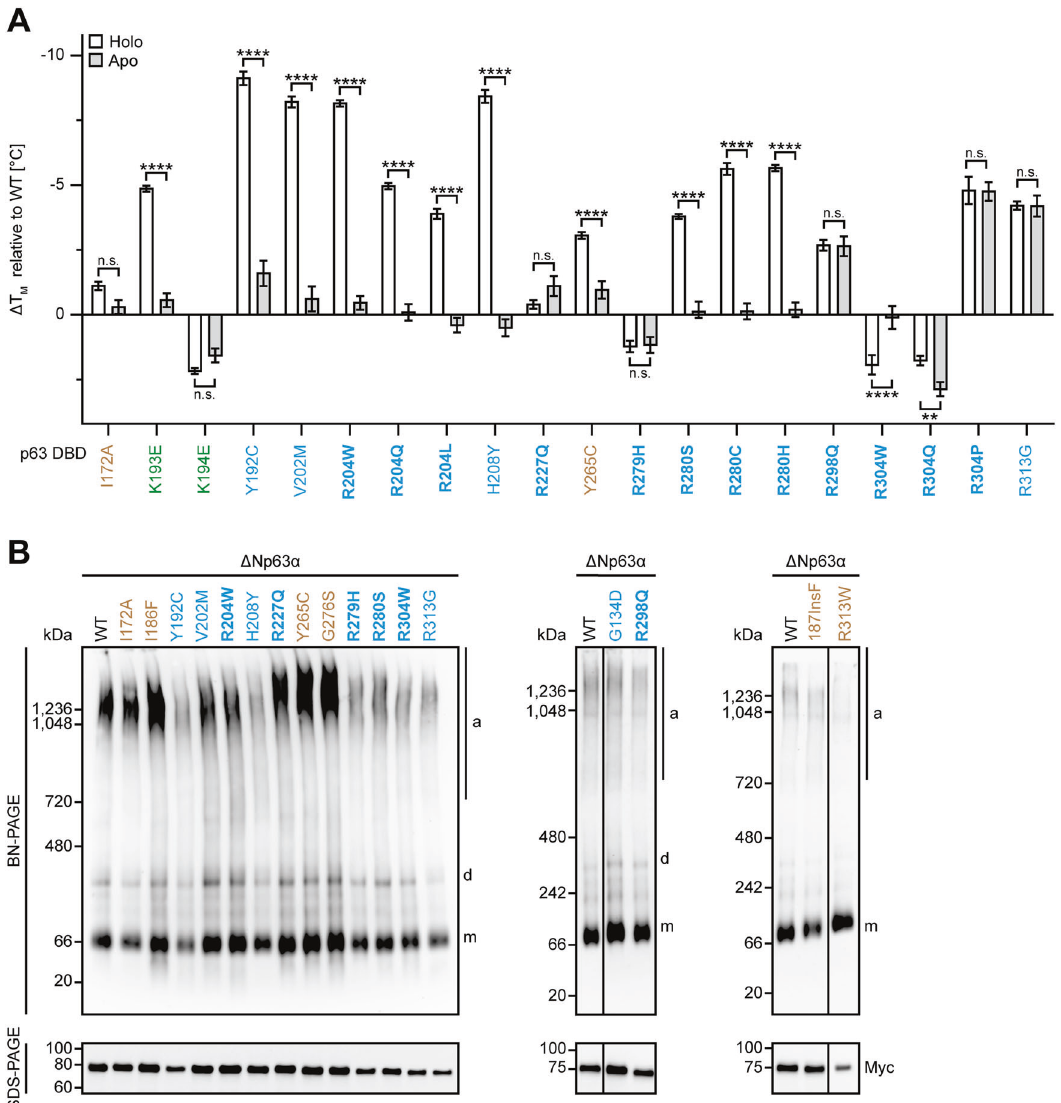
Fig. 4 p63 DBD mutation affect the thermodynamic stability of the domain without inducing its aggregation. A Melting temperature difference ( Δ TM) of mutant DBDs. The melting temperatures (Supplementary Fig. S4A) were referenced to the holo or apo form of the p63 WT DBD, respectively. The bar diagram shows the mean melting temperature and error bars the corresponding SD calculated by error propagation ( n = 3). Statistical signi fi cance was assessed by ordinary one-way ANOVA followed by Tukey ’ s post hoc test (Supplementary Table S3). n.s. P > 0.05, * P ≤ 0.05, ** P ≤ 0.01, *** P ≤ 0.001, **** P ≤ 0.0001. B BN-PAGE of Δ Np63 α WT and indicated ELA and arti fi cial DBD mutants. Cell lysates were subsequently analysed by BN-PAGE (upper panel) and SDS-PAGE (lower panel) followed by WB using α -Myc antibody (Supplementary Fig. S7). Oligomeric states are indicated by ‘ m ’ (monomer) and ‘ d ’ (dimer), while ‘ a ’ marks high molecular weight species corresponding to aggregates. A , B Mutations related to ELA syndrome are coloured in blue, mutations related to SHFM4 in green and arti fi cial mutants in brown. Hotspot mutations are highlighted in Fig. S6B). In contrast, the dead mutant R304W displayed a very low 53% of Δ Np63 α binding regions were in an open chromatin number of binding regions mostly located at the promoters (Fig. conformation, of which 50% were open only in the presence of 6E) and such regions were in an open conformation (87%) and p63 binding (Supplementary Fig. S6B). were open independently of p63 (92%) (Supplementary Fig. S6B). Next, we analysed the ability of mutant p63 to associate with To identify potential differences in the preferred DNA binding chromatin. The R227Q and R298Q mutants bound only to a subset sequence, we performed de novo motif discovery on the top of regulatory regions bound by Δ Np63 α WT, and with a reduced 1000 sequences bound by p63 WT, p63R227Q or p63R298Q. As signal intensity (Fig. 6D + E; Supplementary Fig. S6C). In addition, expected, the most prevalent DNA motif identi fi ed in the DNA regions enriched in p63R298Q binding accumulated in promoters, binding regions bound by p63 WT corresponded to a canonical rather than in distal regions (Fig. 6E). Interestingly, most p63R227Q p63 binding site located in the centre of most binding regions and p63R298Q binding regions were enriched for regulatory (90%) (Fig. 6F; Supplementary Fig. S6D). The second de novo motif regions that were in an open conformation (73% and 75% corresponded to a canonical binding site for the KLF family of respectively), and that were in an open conformation indepen- transcription factors (identi fi ed in 18.5% of the sequences) dently of p63 binding (64% and 70% respectively) (Supplementary